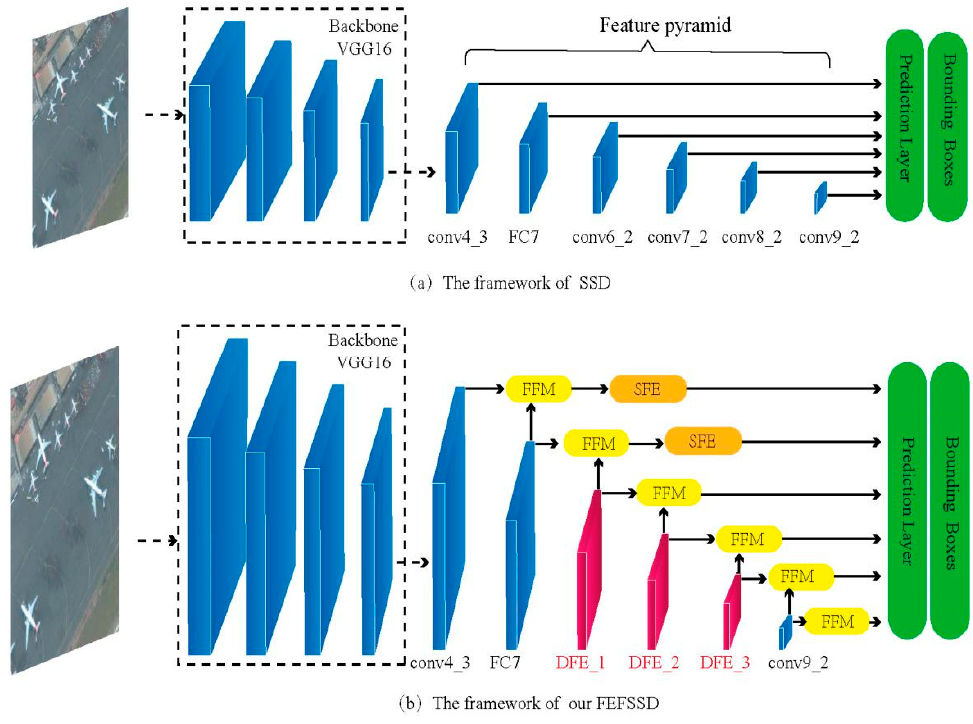
Figure 1. Networks of Single Shot MultiBox Detectors (SSD) and Single Shot Object Detection with Feature Enhancement and Fusion (FFESSD). ( a ) The framework of SSD and ( b ) the framework of FFESSD. The FFM is the Feature Fusion Module, the SFE is the Shallow Enhancement Module, and the DFE is the Deep Enhancement Module.